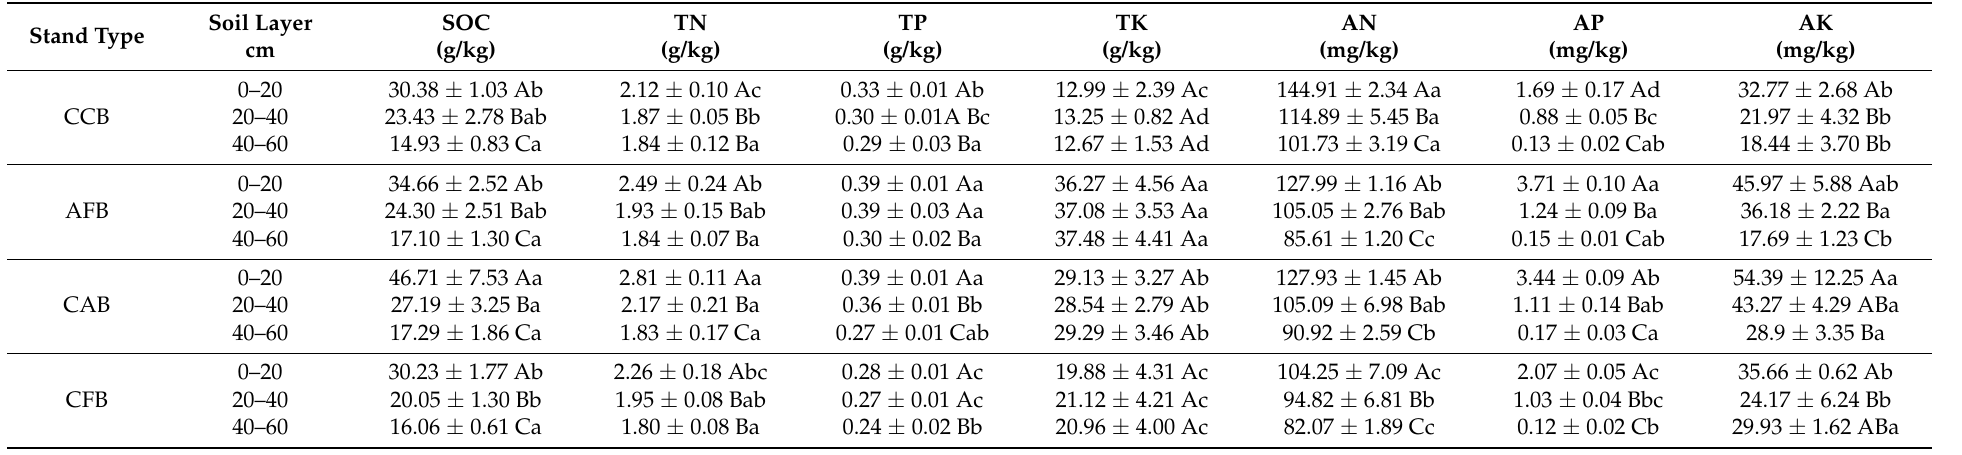
Table 2. Soil characteristics for different bamboo–broadleaf mixed forests.